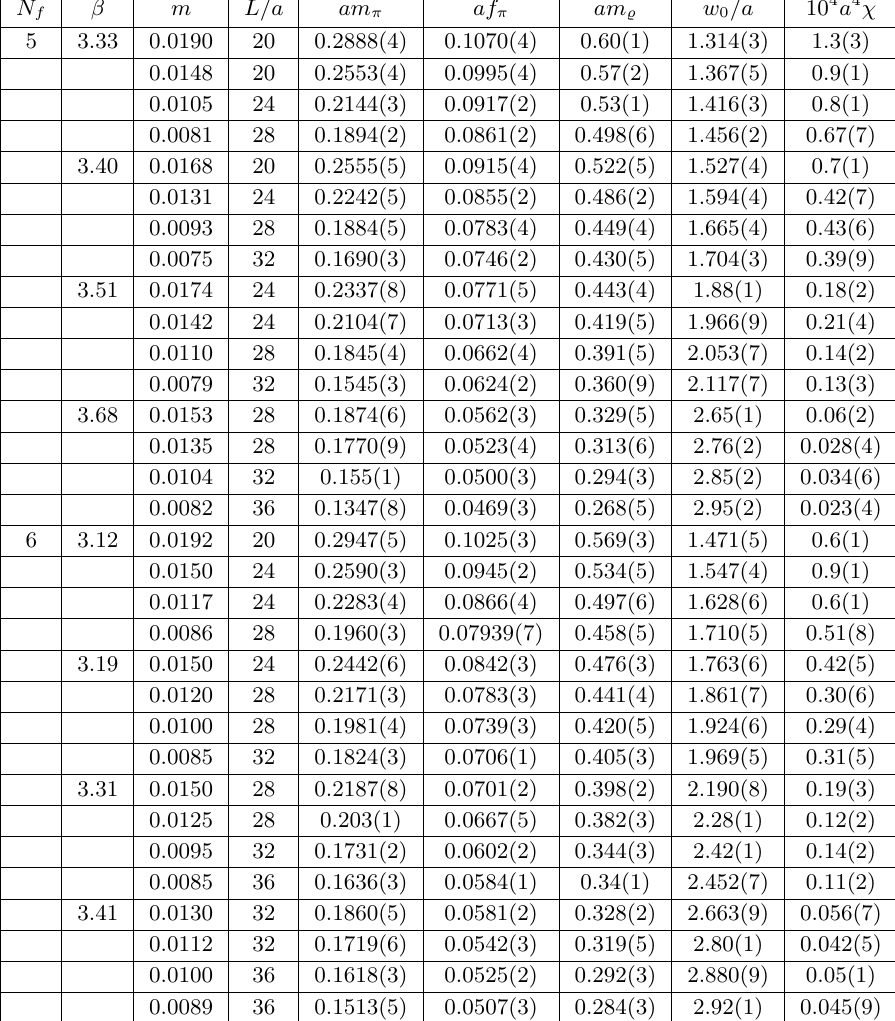
Table 4 . Data for N f = 5 ;